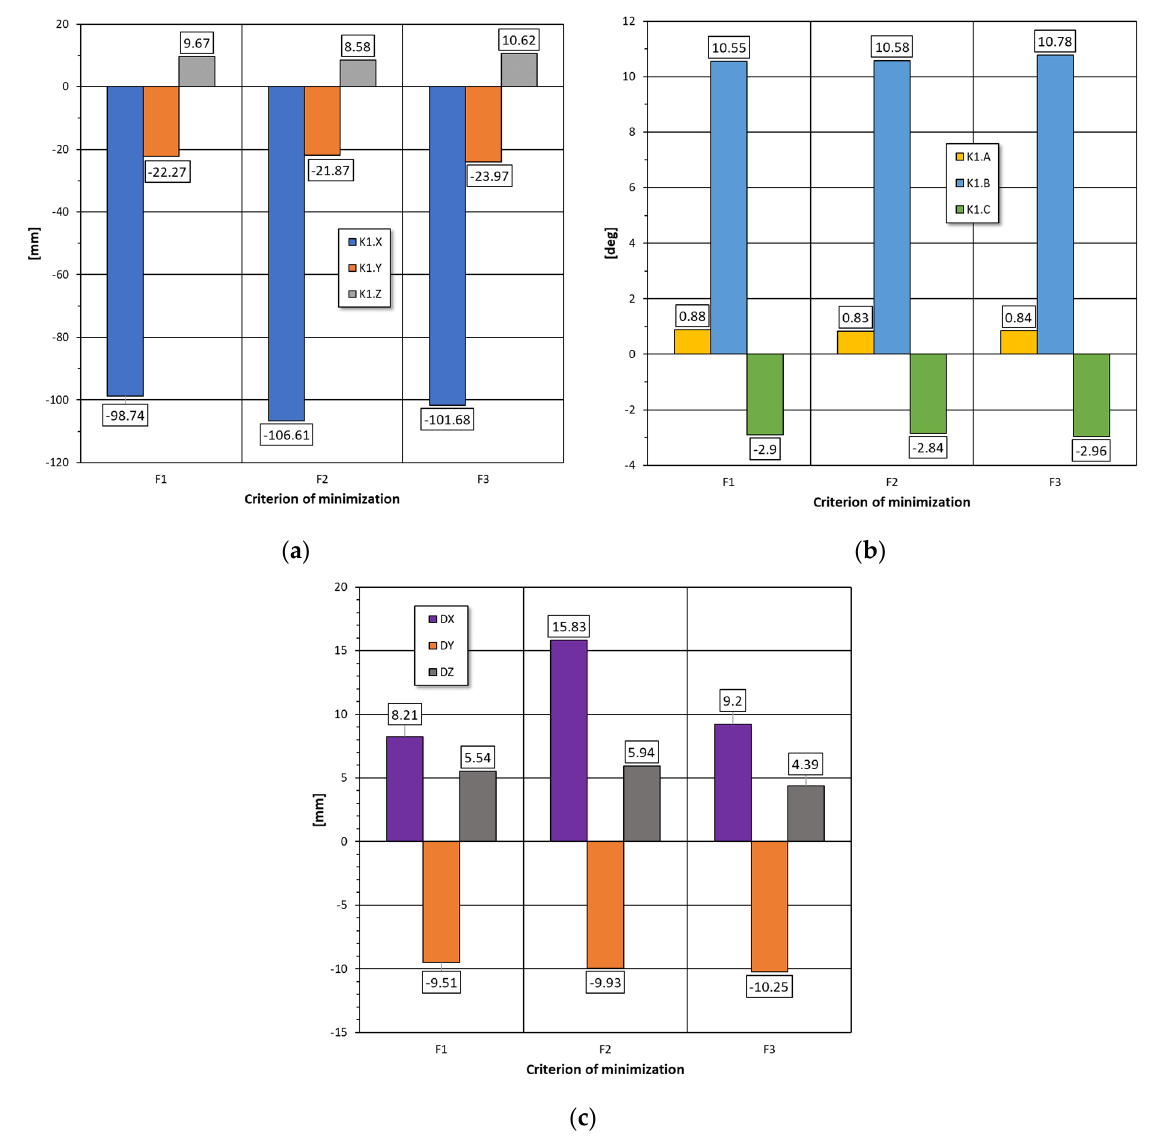
Figure 12. Values of the sought parameters derived from the minimization of the objective func- tions under consideration: ( a ) components of the translation vector of the coordinate system X T Y T Z T to the point K L , ( b ) angles of rotation of the coordinate system X T Y T Z T , and ( c ) shift of the laser grid central point (pattern) in the coordinate system X B Y B Z B .